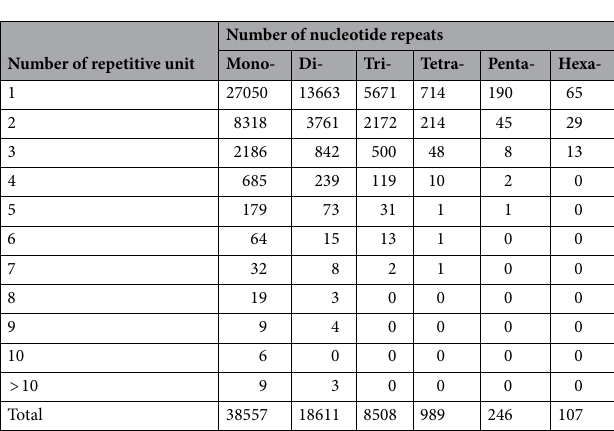
Table 3. Repeat motif based distribution of identified